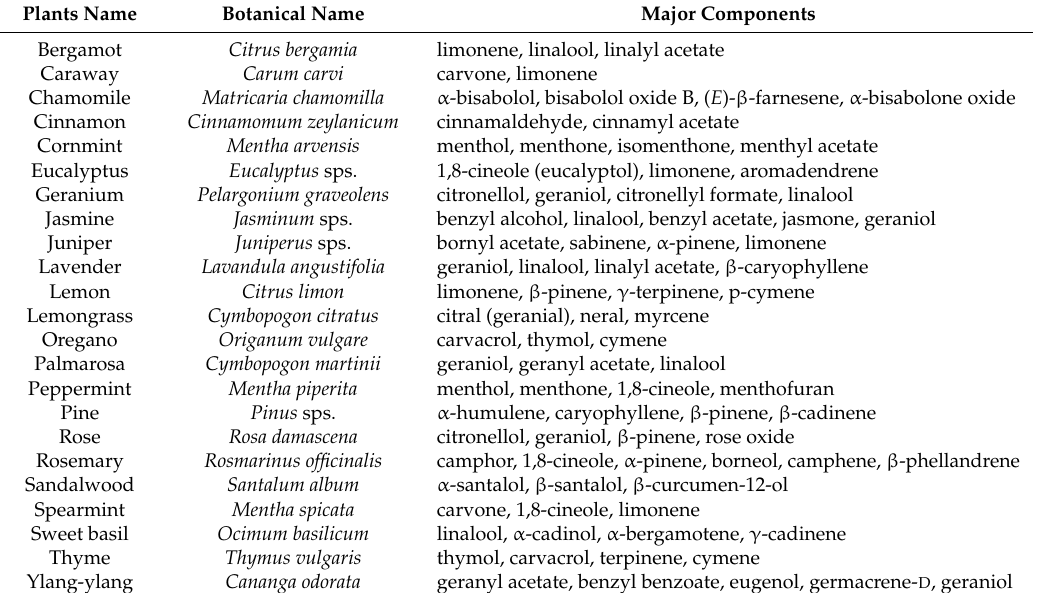
Table 1. Some of the important essential oil-bearing plants and their major